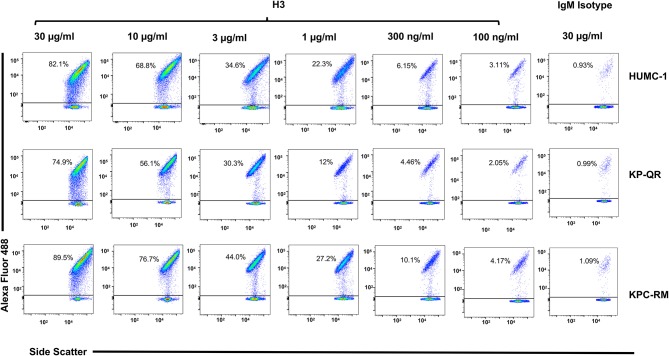
Monoclonal antibody (mAb) clone H3 targeting Hyr1 peptide #5 binds Gram-negative bacteria (GNBs) in a dose-dependent manner. MAb clone H3 (and IgM isotype control) were evaluated for binding to HUMC-1, KP-QR, and KP-RM at concentrations ranging from 30 to 0.1 μg/ml. The extent of binding was quantified by flow cytometry after staining the antibodies with Alexa 488-conjugated secondary antibody. Data were represented in a scatter plot highlighting the percentage of bacteria that were bound by the Abs.